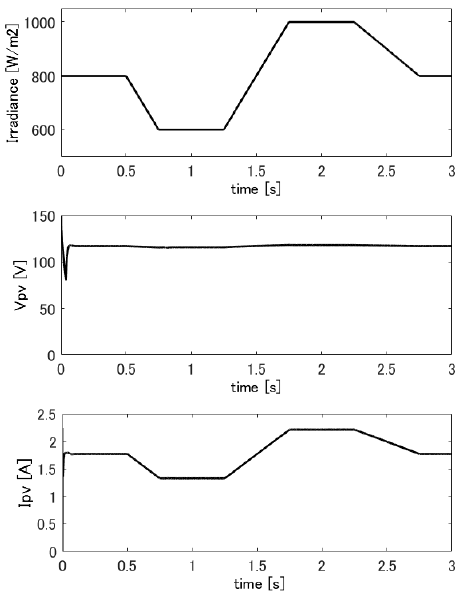
Figure 19. Responses of the FOCV control with the varying irradiance.